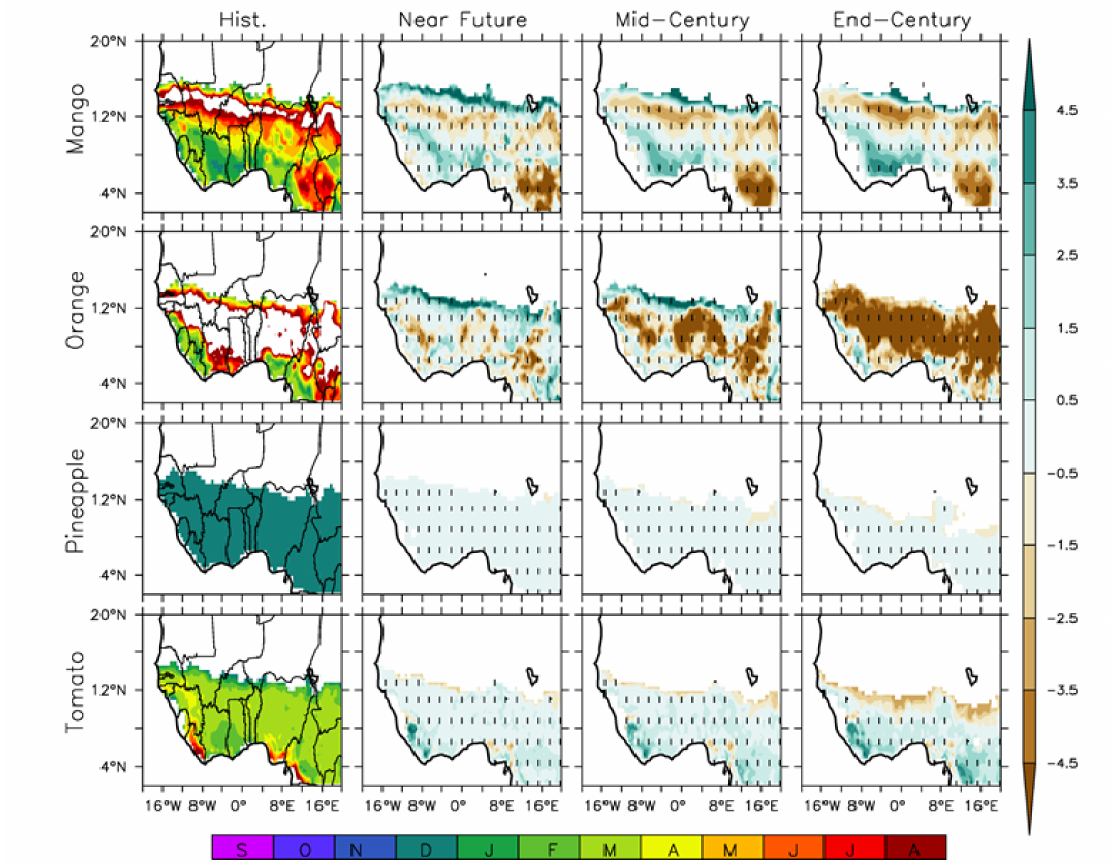
Figure 10. Same as Figure 7 but for the fruit and horticultural